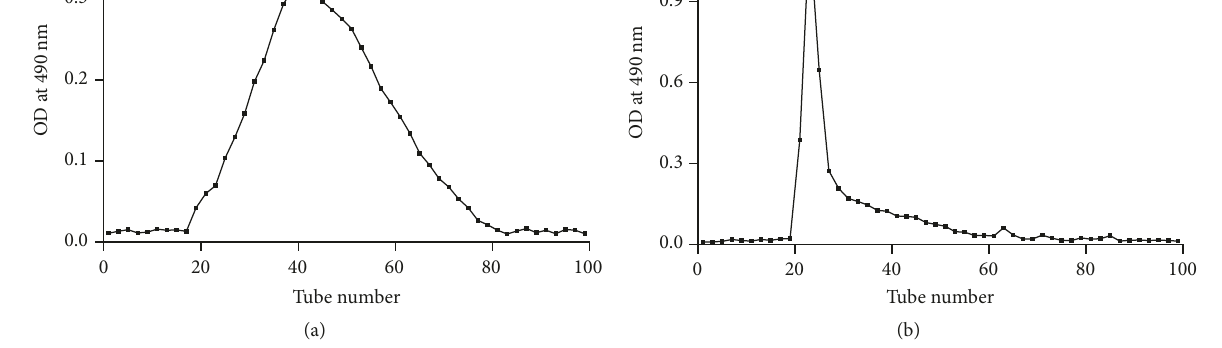
Figure 3: Sephadex G-100 profiles of (a) RGP1 and (b) RGP2.